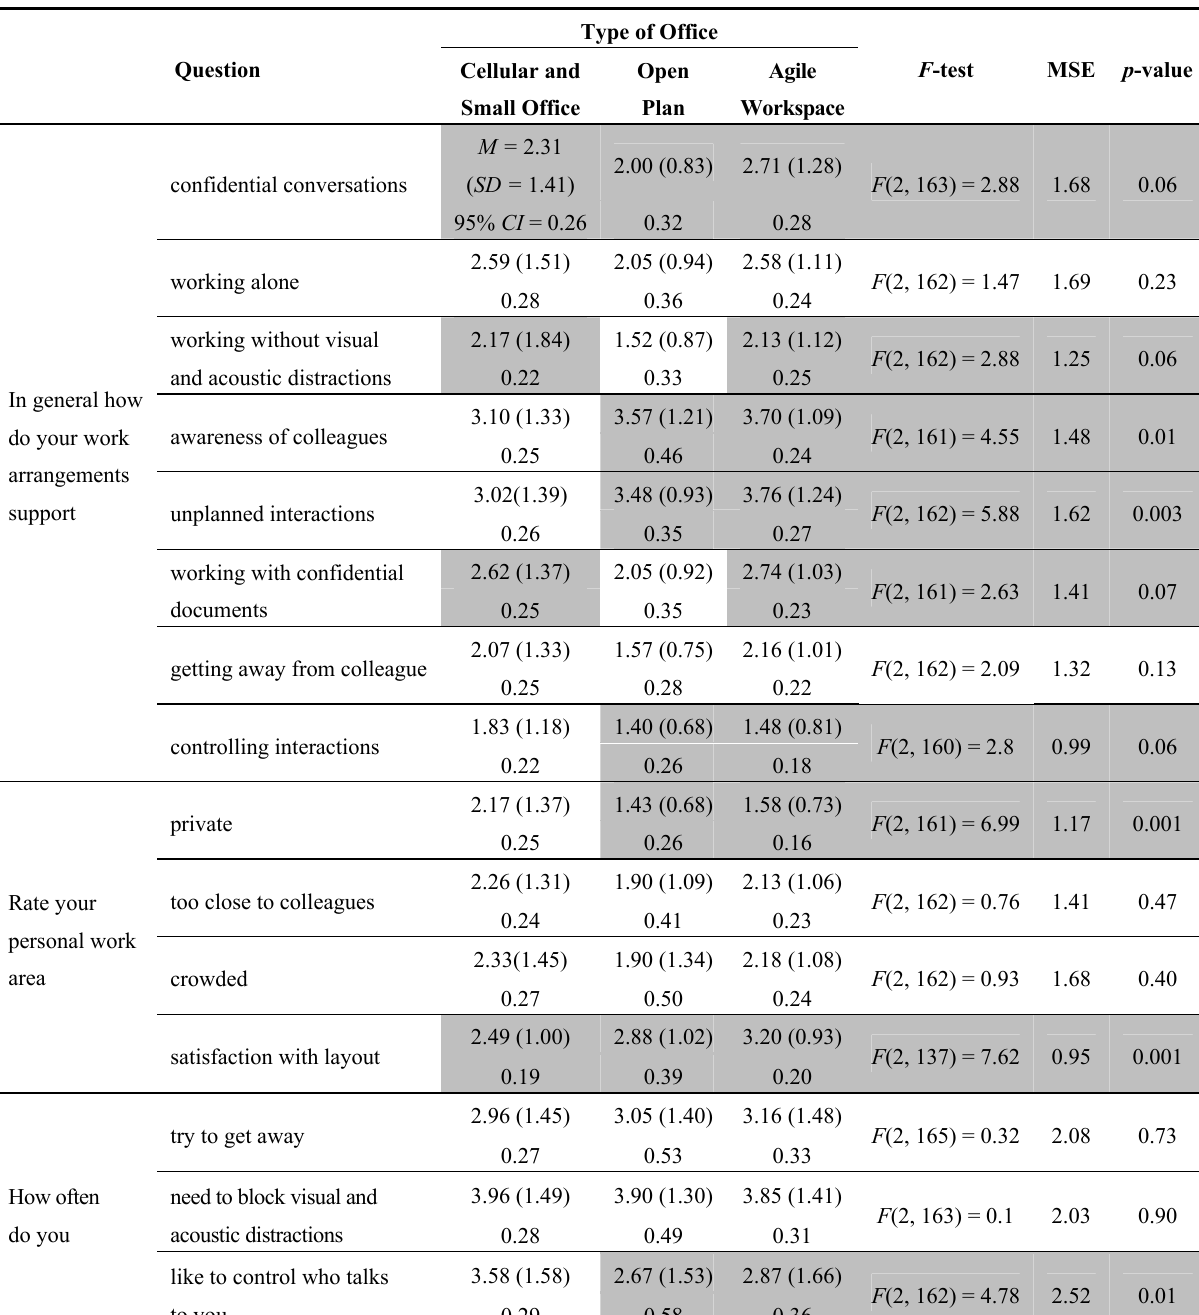
Table 5. An overview of questions 1 to 15 about the experience of privacy, crowding and satisfaction (1 = Not at all, 5 = Extremely or Many times a day). Scores are highlighted where they are statistically similar to each other and different from the other score. SD: Standard deviation; MSE: Mean Square